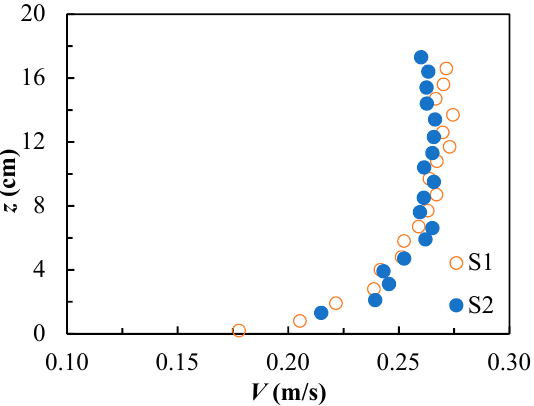
Figure 5. Velocity profiles taken at mid-axis, 0.5 m (S1) and 1.5 m (S2) upstream of the pier.